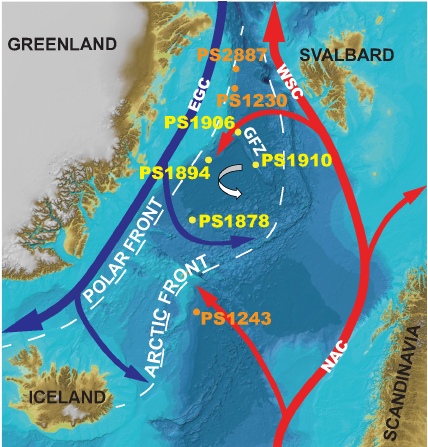
Fig. 1. Present day surface water circulation in the Nordic Seas. Cores used in this study are marked by yellow dots; other cores mentioned in text are marked by orange dots. Red arrows indi- cate Atlantic Water, blue arrows – Polar Water, white broken lines – oceanographic fronts. White arrow – present-day deep convec- tion (Marshall and Schott, 1999). EGC – East Greenland Current, NAC – North Atlantic Current, WSC – West Spitsbergen Current, GFZ – Greenland Fracture Zone. Bathymetry from The Interna- tional Bathymetric Chart of the Arctic Ocean (http://www.ibcao. org,